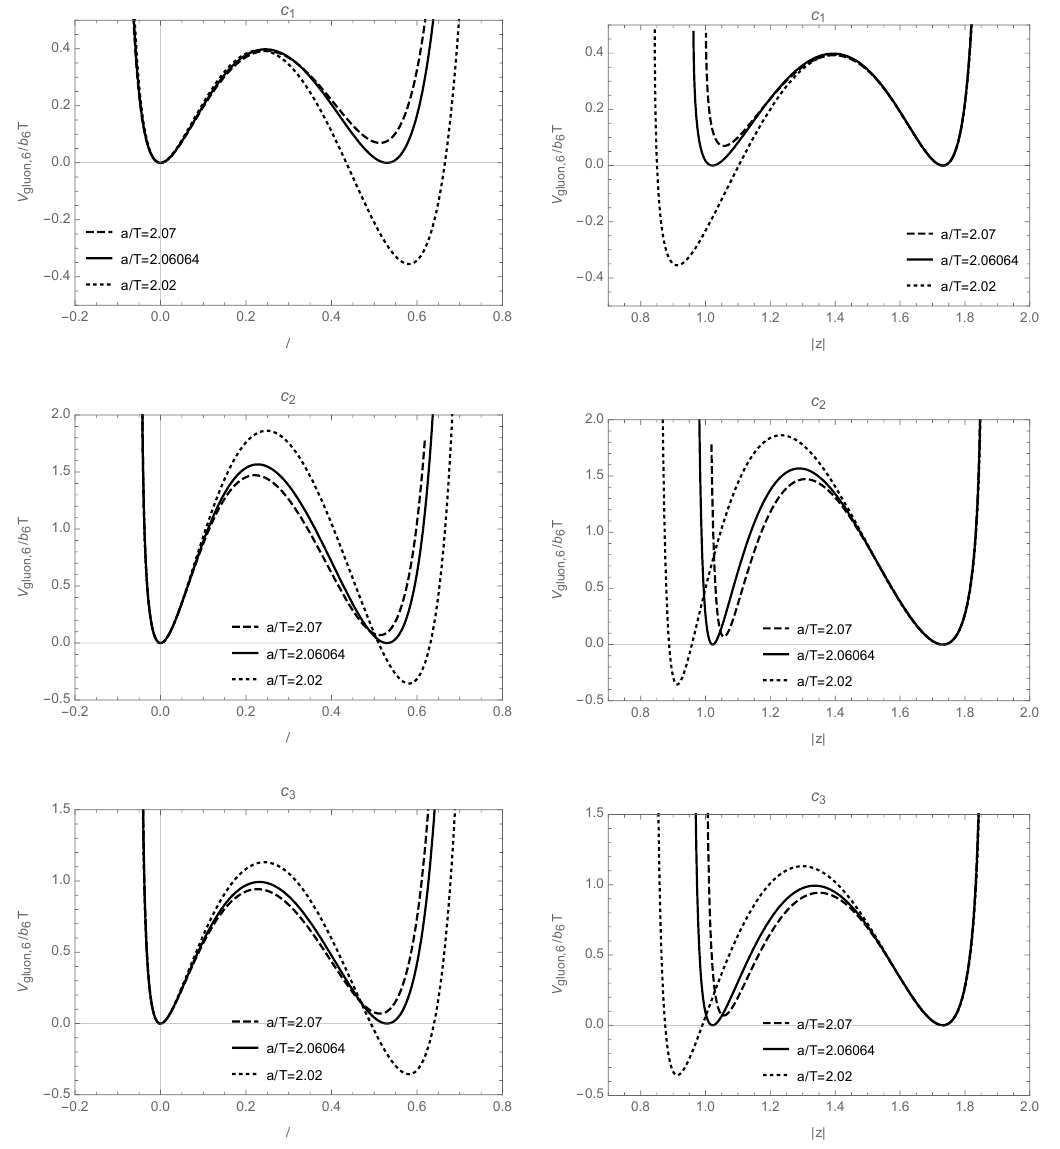
Figure 6 . The potential V gluon ; 6 ( L; T ) =b 6 T around the critical temperature ~ a c = 2 : 06064 as a function of ‘ (left) and j z j (right) on the three di(cid:11)erent lines c 1 , c 2 , c 3 linking the two minimum points given in (3.43) and (3.45).